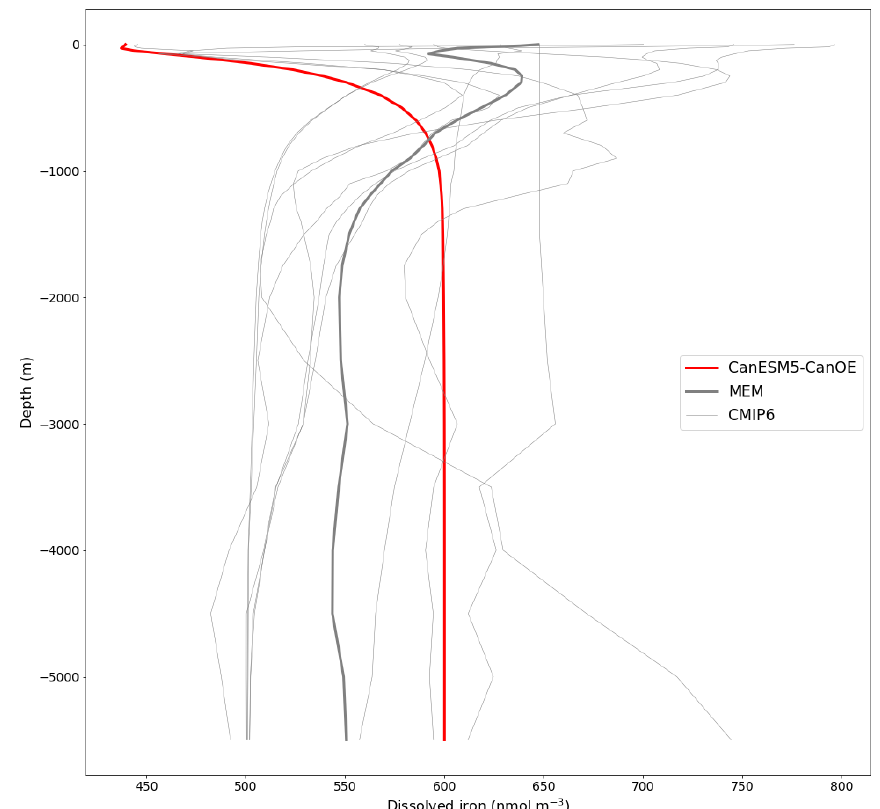
Figure 13. Global mean depth profiles of dissolved iron concentration for CanESM5-CanOE and other CMIP6 models that published this field. GFDL-CM4 is excluded because it has very high concentrations ( > 2000nmolm − 3 ) near the surface. The thick red line represents CanESM5-CanOE, the thin grey lines individual CMIP6 models, and the thick grey line the model ensemble mean (excluding CanESM5- CanOE and